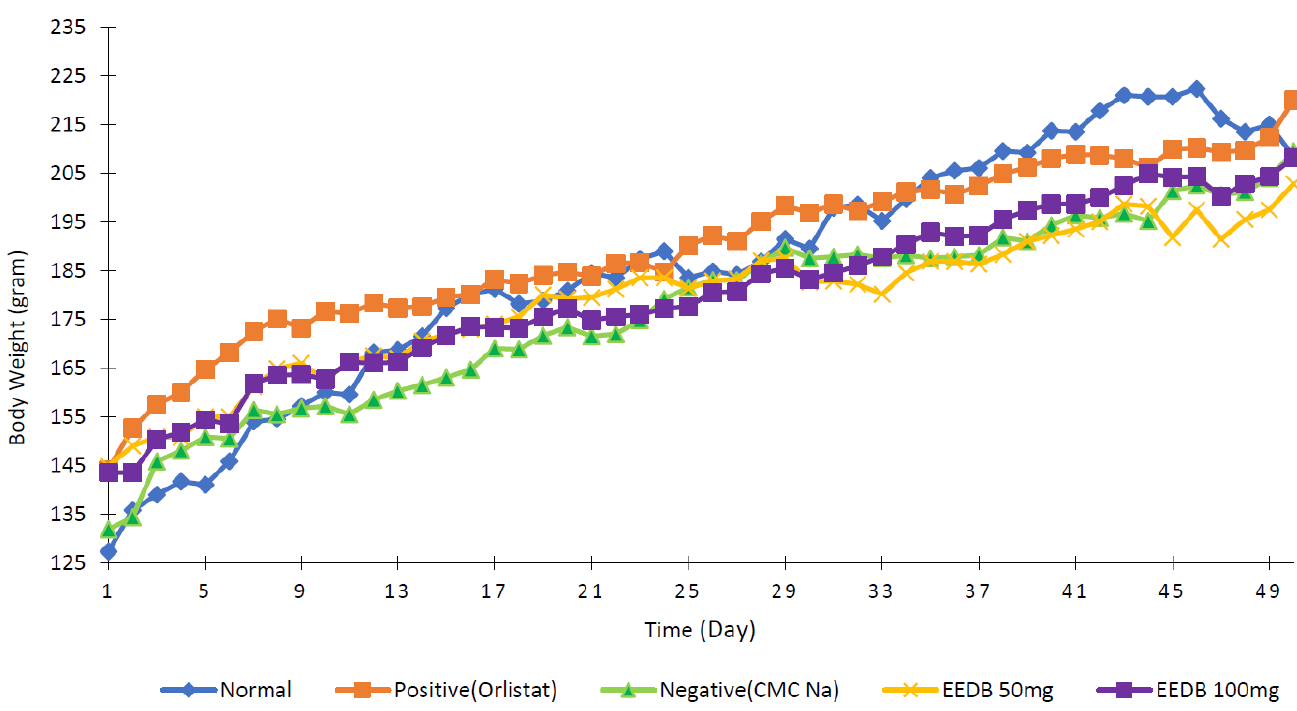
Figure 3. Rats’ body weight chart during the 50 days.